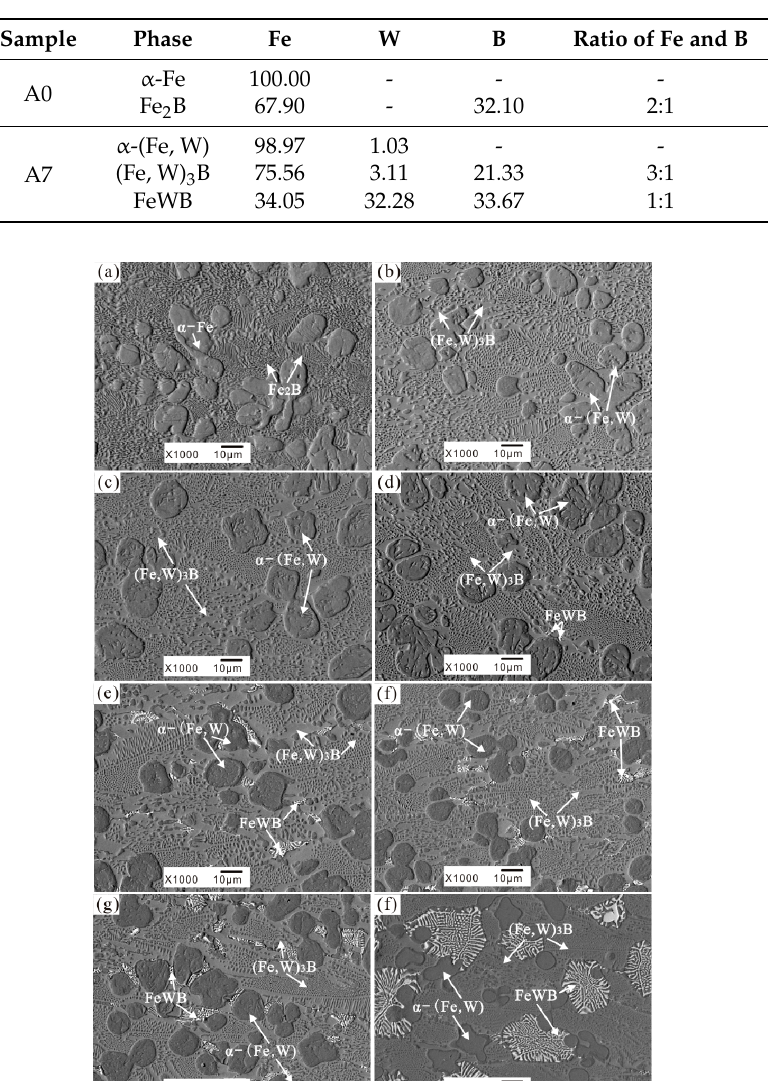
Figure 2. The as-cast microstructures of Fe-3.5B alloys containing different amounts of tungsten ( a ) A0-0 wt % W ( b ) A1-2 wt % W ( c ) A2-4 wt % W ( d ) A3-6 wt % W ( e ) A4-8 wt % W ( f ) A5-11 wt % W